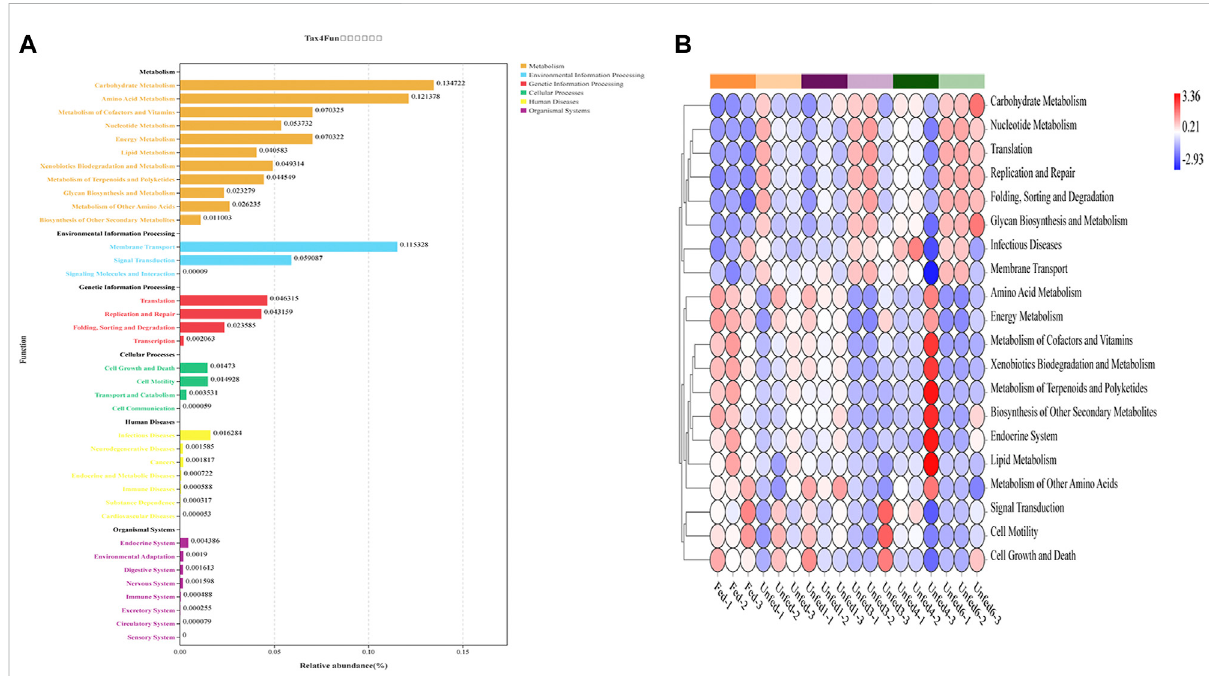
FIGURE 3 16S rRNA gene-predicted functional pro fi les obtained with Tax4Fun. (A) Function distribution, The vertical axis arranges the KEGG pathways of different levels, and the length of the column indicates the corresponding functional abundance in the pathway. (B) Heatmap, the vertical axis is functional classi fi cation, the horizontal axis is the sample, and the color indicates the